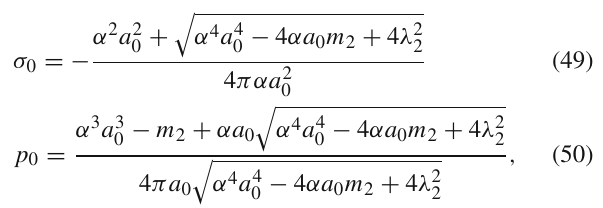
masses per length is m 1 = 0 . 2 m 2 . Different values of λ 2 /λ e are used in each plot, where β = a 0 The WEC is satisfied in the dark grey region but not in the light grey